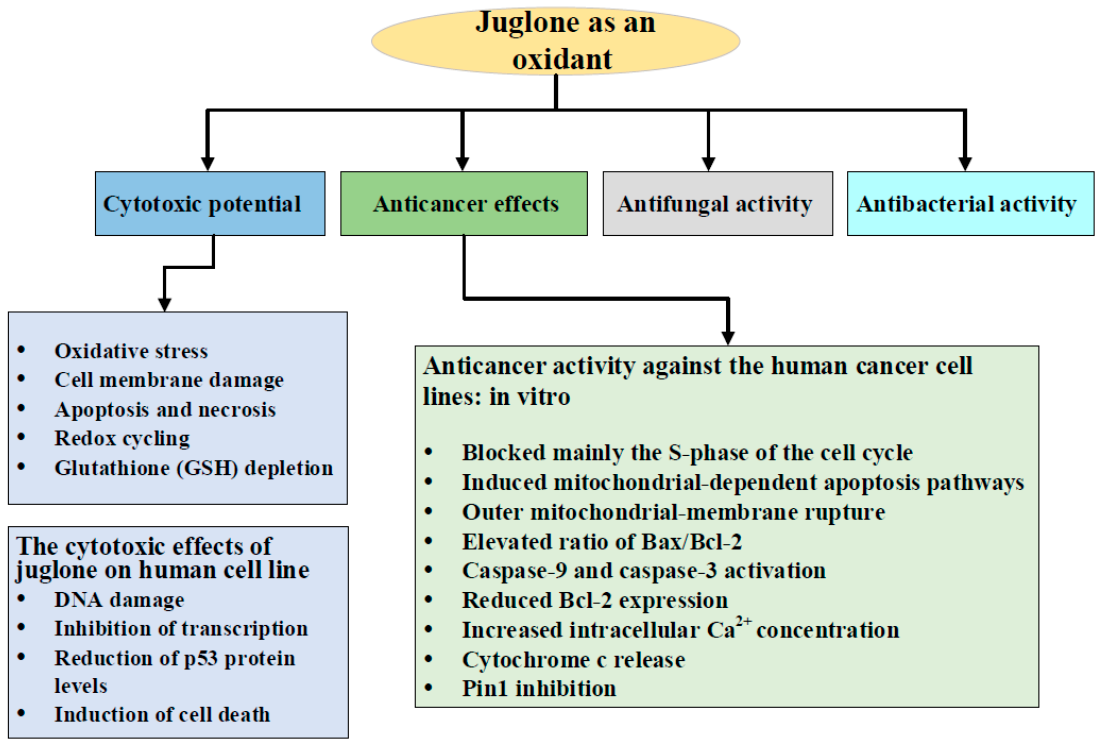
Figure 3. The schematic diagram showing the oxidant potential of juglone and its therapeutic applications.